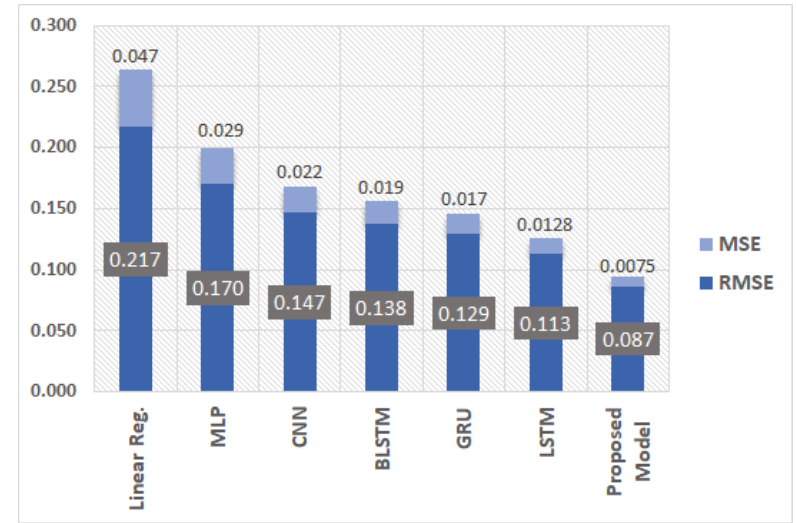
Figure 6. RMSE and MSE values of 6 existing models including linear regression and the proposed model. It is clear from the figure that our model outperformed the existing models for the same